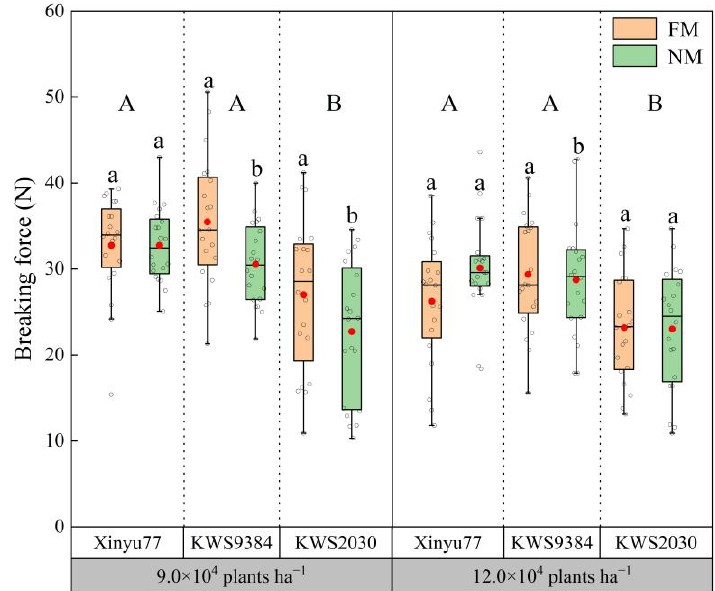
Figure 3. Differences in the stalk breaking forces between film mulch (FM) and no-film (NM) planting under different planting densities and cultivars. The boxes represent IQRs, the whiskers indicate reasonable sample borders (Tukey tests), the horizontal line in each box indicates the median, and the solid red dot shows the mean. Different lowercase letters indicate significant differences ( p < 0.05) between the FM and NM treatments. Different capital letters indicate significant differences ( p < 0.05) among cultivars. Table 1. Differences of maize plant morphology and basal internode morphology between film mulch (FM) and no-film (NM)